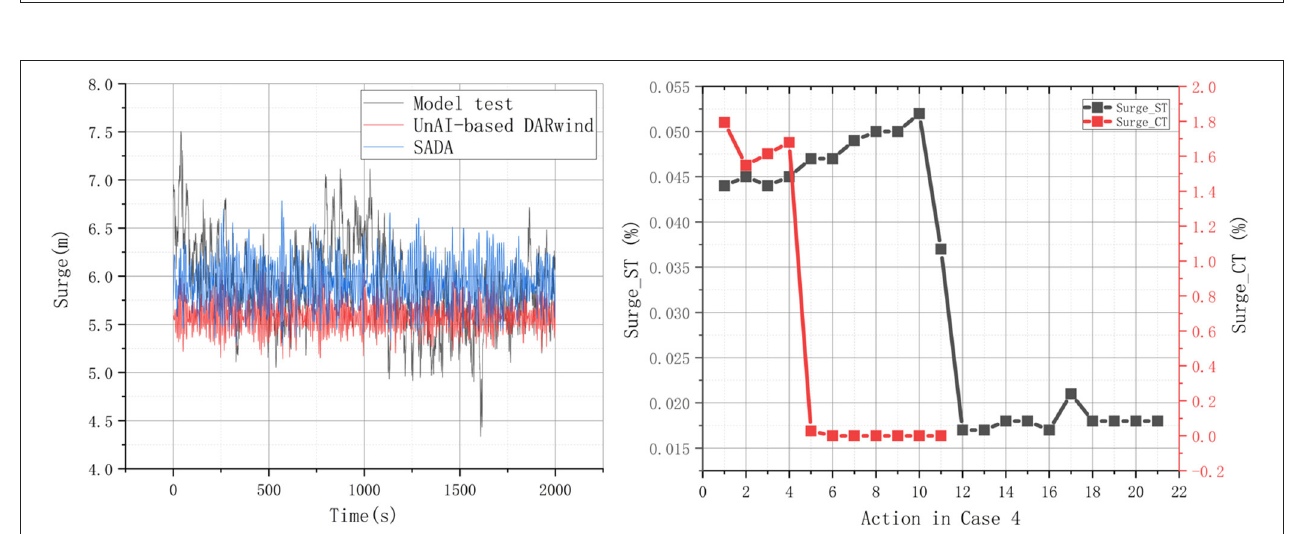
FIGURE 8 | Actions of platform motions in three cases.